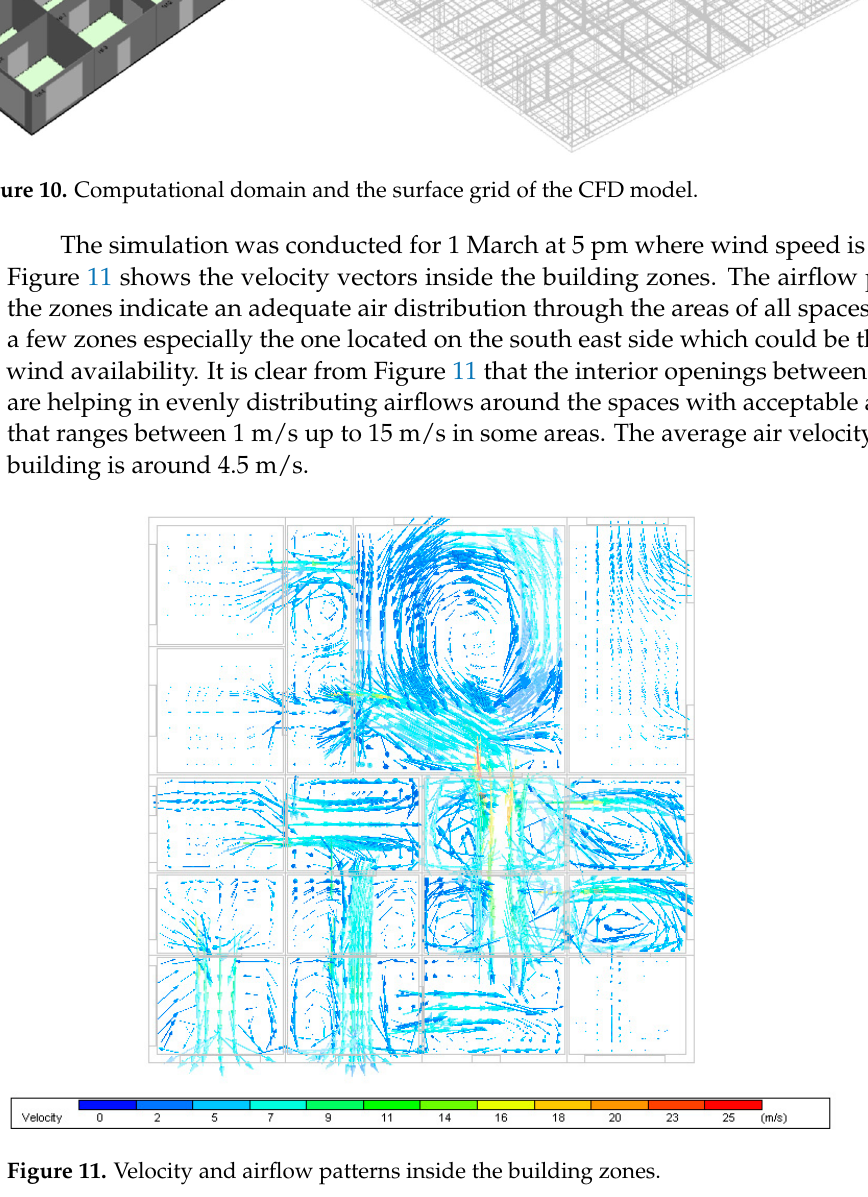
Table 3. Summary of the CFD boundary conditions of selected surfaces for each orientation of the building model.